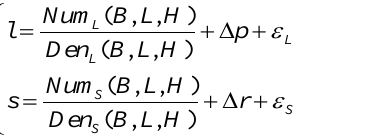
According to the epipolar geometry defined by the PTE model, the rectified images are resampled via bicubic interpolation. The resampling is undertaken pixel by pixel along every epipolar line on the original stereo